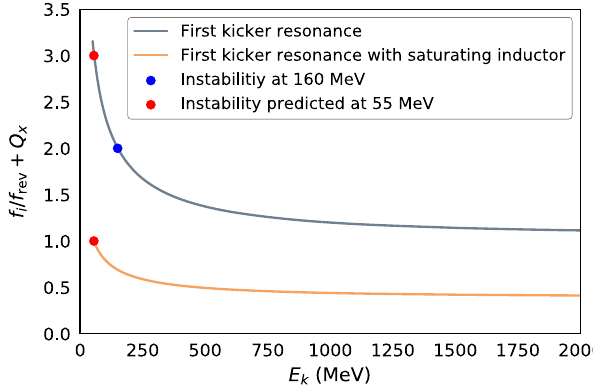
FIG. 20. Left-hand side of Eq. (3) as a function of the kinetic energy up to 2 GeV for the first kicker resonance with the unmodified (grey line) and the modified (orange line) electrical circuit of the extraction kicker system. The blue point marks the instability at 160 MeV observed in the PSB. The red points are predictions for instabilities at ∼ 55 MeV. For the modified circuit the predicted instability at 55 MeV would not be relevant since the future injection energy will be at 160 MeV. No instability is